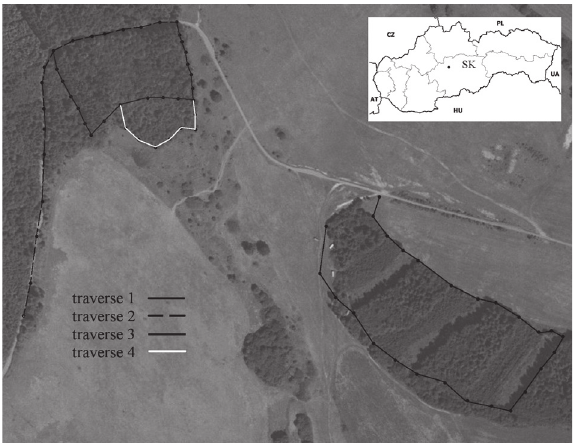
Fig. 2. The point field location and the course of individual compass